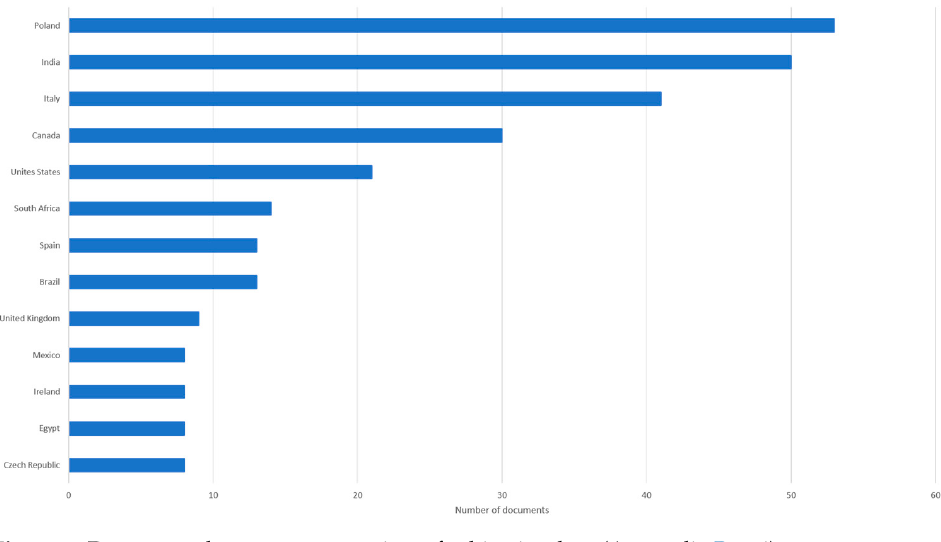
Figure 7. Documents by country or territory for biostimulant (Appendix B—vi). Only the countries with a minimum of 8 publications are shown in this graph.